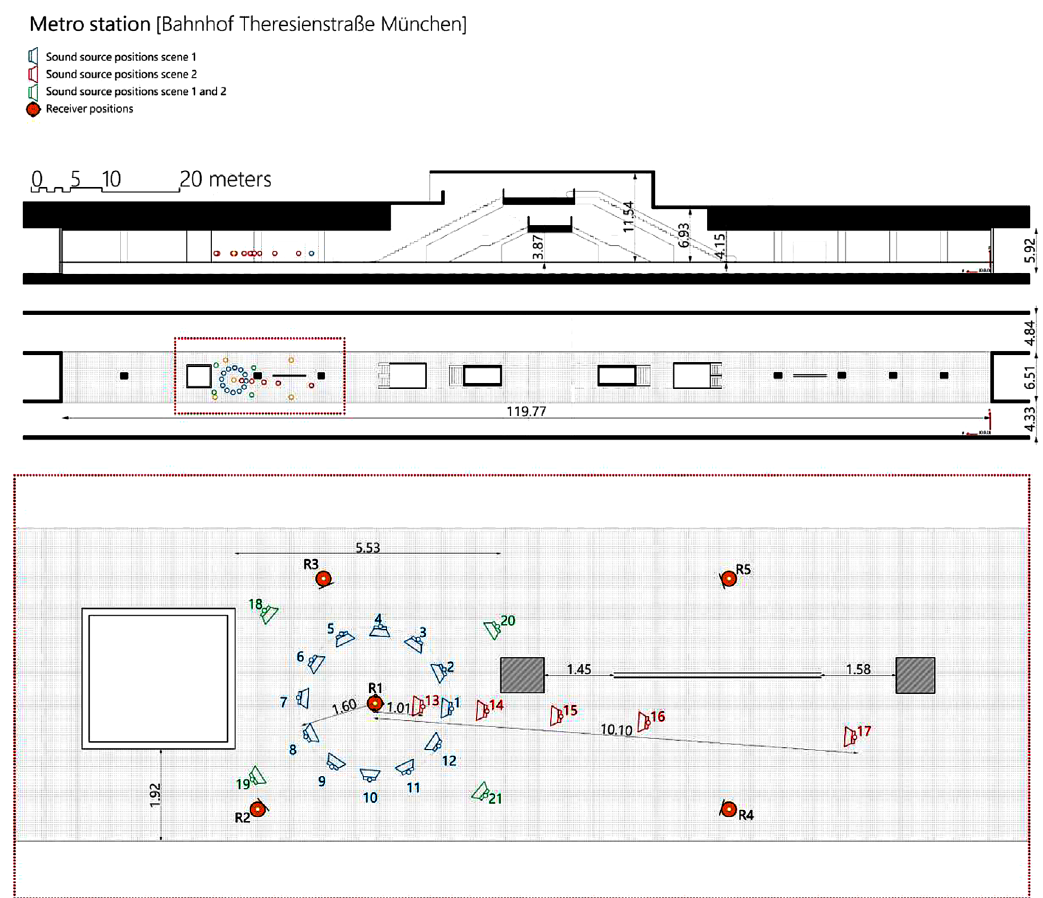
Figure 2. Upper panels: Cross section (top) and fl oorplan (middle) of the underground station environment with dimensions in meters. Lower panel: Magni fi ed view of the area with receivers (denoted with R) (R1 – 5, yellow head and microphone symbols) and sources (loudspeaker symbols) indicating their orientation in the horizontal plane; all were located at 1.6 m height. The blue loudspeakers are part of scene 1 and the red loudspeakers of scene 2. Green loudspeakers can be used in both scenes for, e.g., interfering